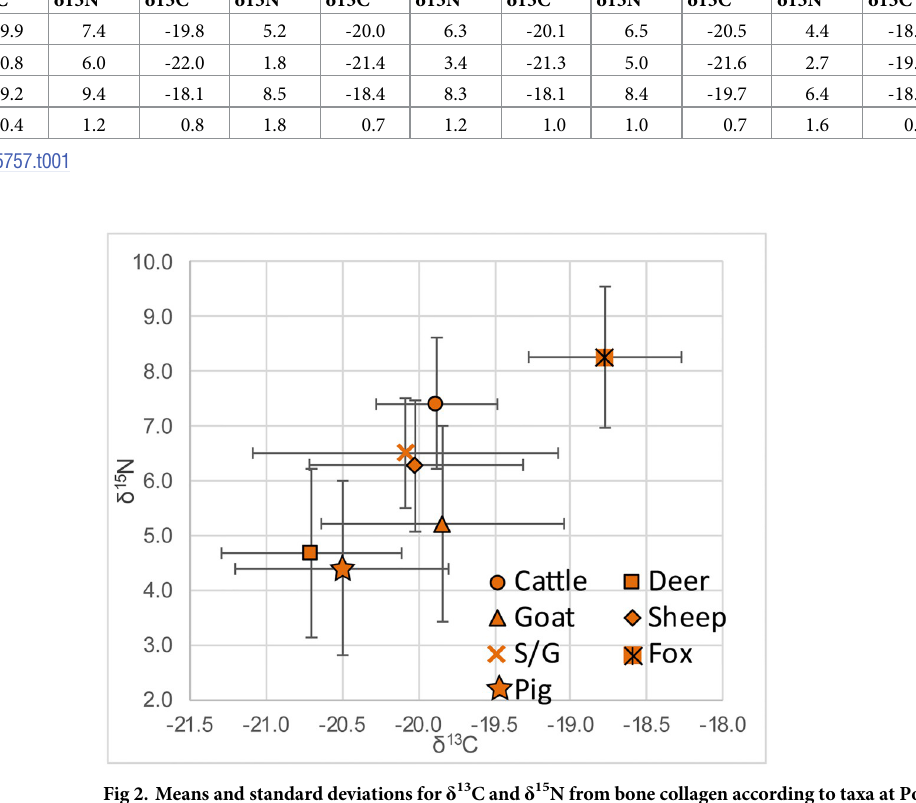
1.8‰. Mean, minimum, maximum, and standard deviation values are listed in Table 1, and means and standard deviations for each taxonomic group are presented in Fig 2. There does not appear to be any relationship between isotopic values and the skeletal element sampled; variability is therefore attributed to individual diet and surrounding environment. With the exception of the single owl specimen, the data for both δ 13 C and δ 15 N are normally distributed for all taxa (Shapiro-Wilk) as well as for within-taxa groupings. We use Tukey’s HSD to iden- tify significant differences in means between taxonomic groups, but exclude the sheep/goat category since it includes samples with combined taxa. Table 1. Mean, minimum, maximum, and standard deviation values of δ 13 C and δ 15 N from bone collagen for animal taxonomic groups. A single value for an owl bone is excluded ( δ 13 C = -18.4‰, δ 15 N = 13.5‰). Deer (n = 43) Cattle (n = 8) Goat (n = 27) Sheep (n = 31) Sheep/Goat (n = 8) Pig (n = 8)